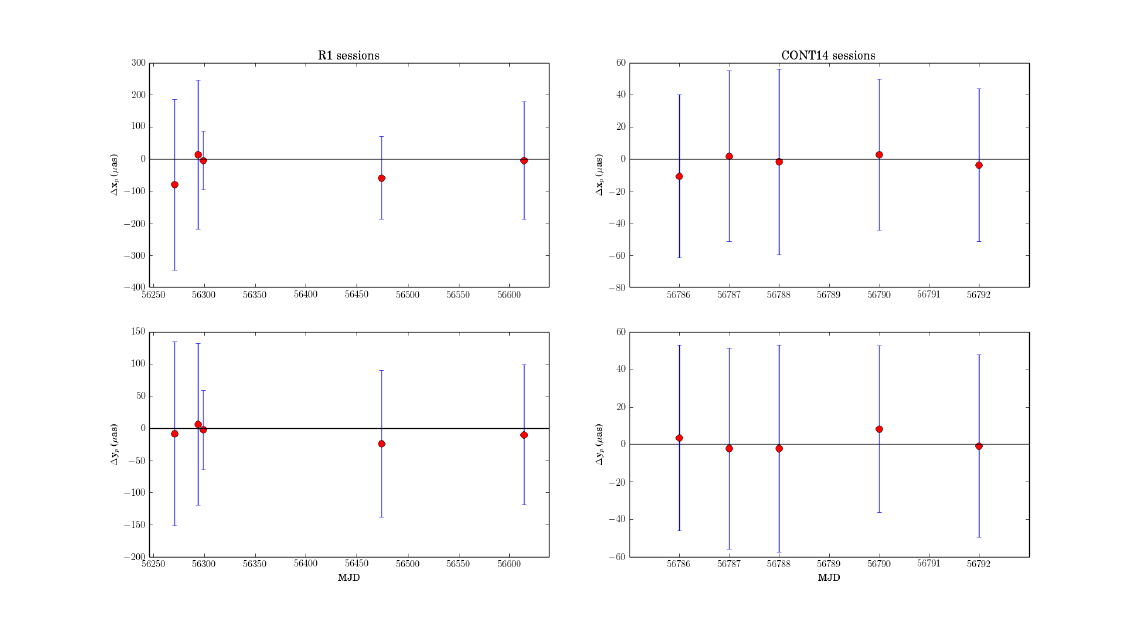
Figure 8: The differences in polar motion components x p (top row) and y p (bottom row) from IVS-R1 (left column) and CONT14 (right column) sessions, when either On or Od data are used in the analysis.